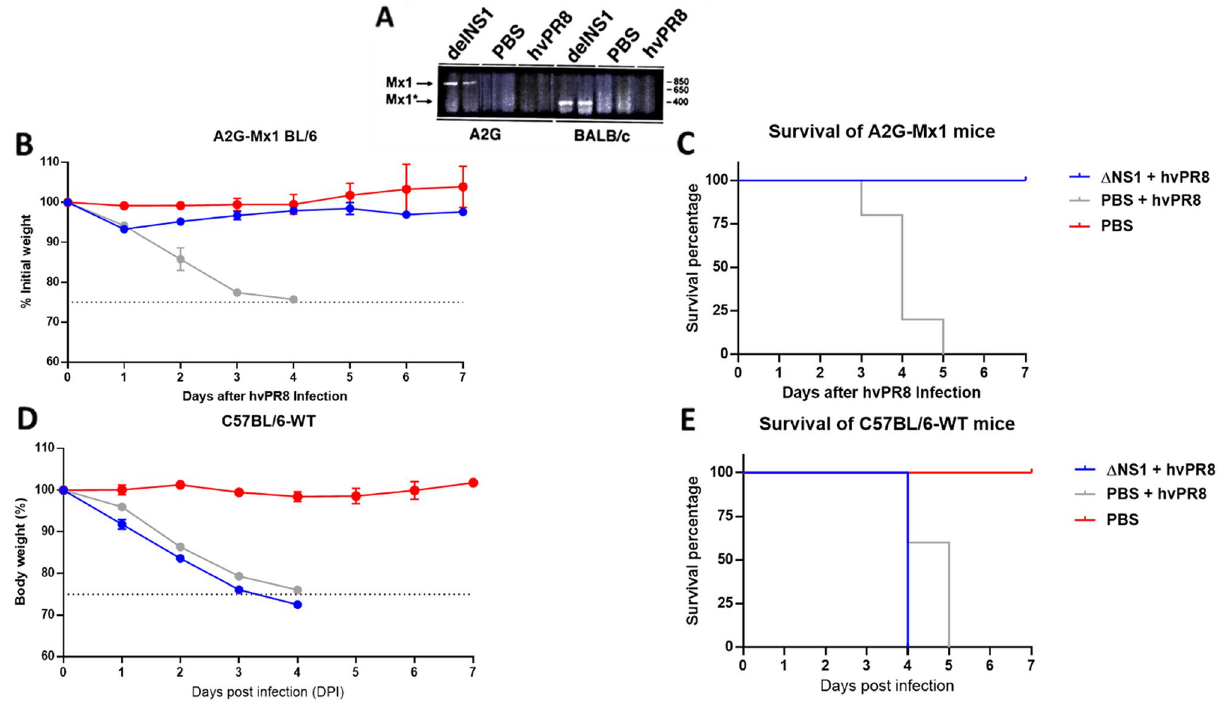
Figure 3. Dose dependent pre-treatment of ΔNS1 protects A2G-Mx1 mice but not wild-type C57BL/6 from a lethal hvPR8 virus challenge. ( A ) Induction of Mx1 specific mRNA expression in ΔNS1 virus infected mice. Groups of two A2G or BALB/c mice were intranasally treated with PBS or 2.5 × 10 5 PFU of ΔNS1 hvPR8 influenza viruses. 24 h post challenge, total RNA present in lung tissues were extracted and were used for RT-PCR reactions using Mx1 specific primers. PCR products were run in an agarose gel; the arrows indicate the predicted size of amplified cDNA from Mx1 genes pf A2G mice (Mx1) and BALB/c mice (Mx1*). ( B , C , D , E ) Sex matched 6 weeks old groups C57BL/6-A2G-Mx1 mice or C57BL/6-wild-type mice were either intranasally pre-treated with PR8-ΔNS1 (5 × 10 6 PFU; n = 5 per group), sterile PBS (n = 5) 12 h before a lethal challenge of hvPR8 (5 × 10 5 PFU; n = 5) or treated with only sterile PBS (n = 2). ( B ) Morbidity of C57Bl/6-A2G-Mx1 mice.